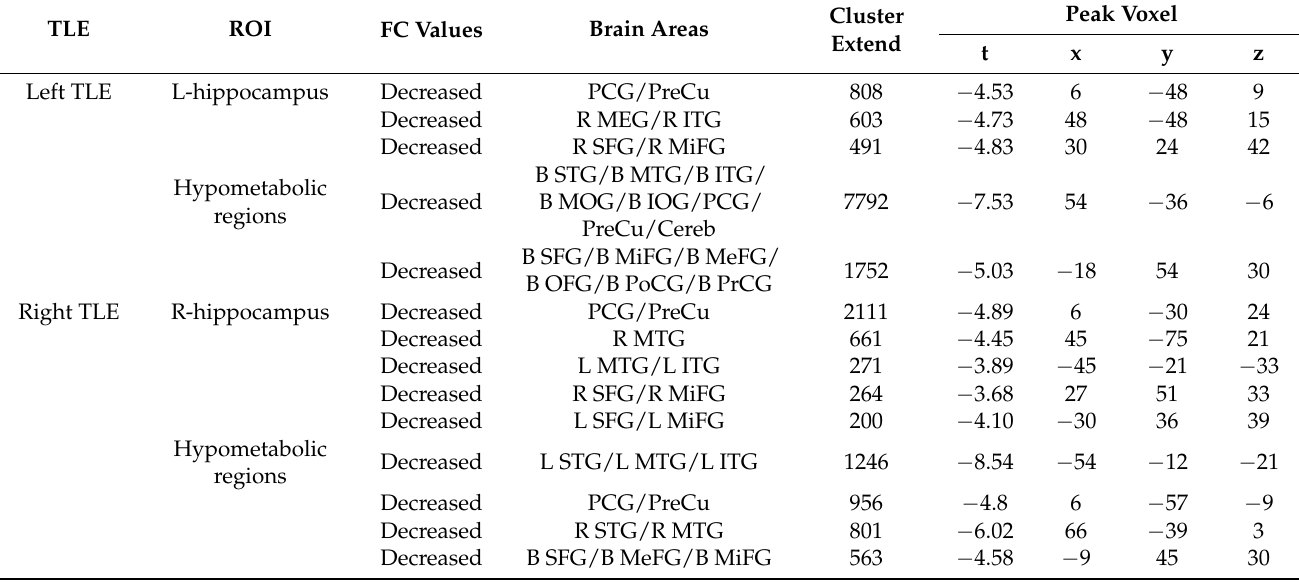
Table 3. Statistical maps and spatial coordinates (MNI space) of brain areas with functional alterations based on different ROIs in patients compared with